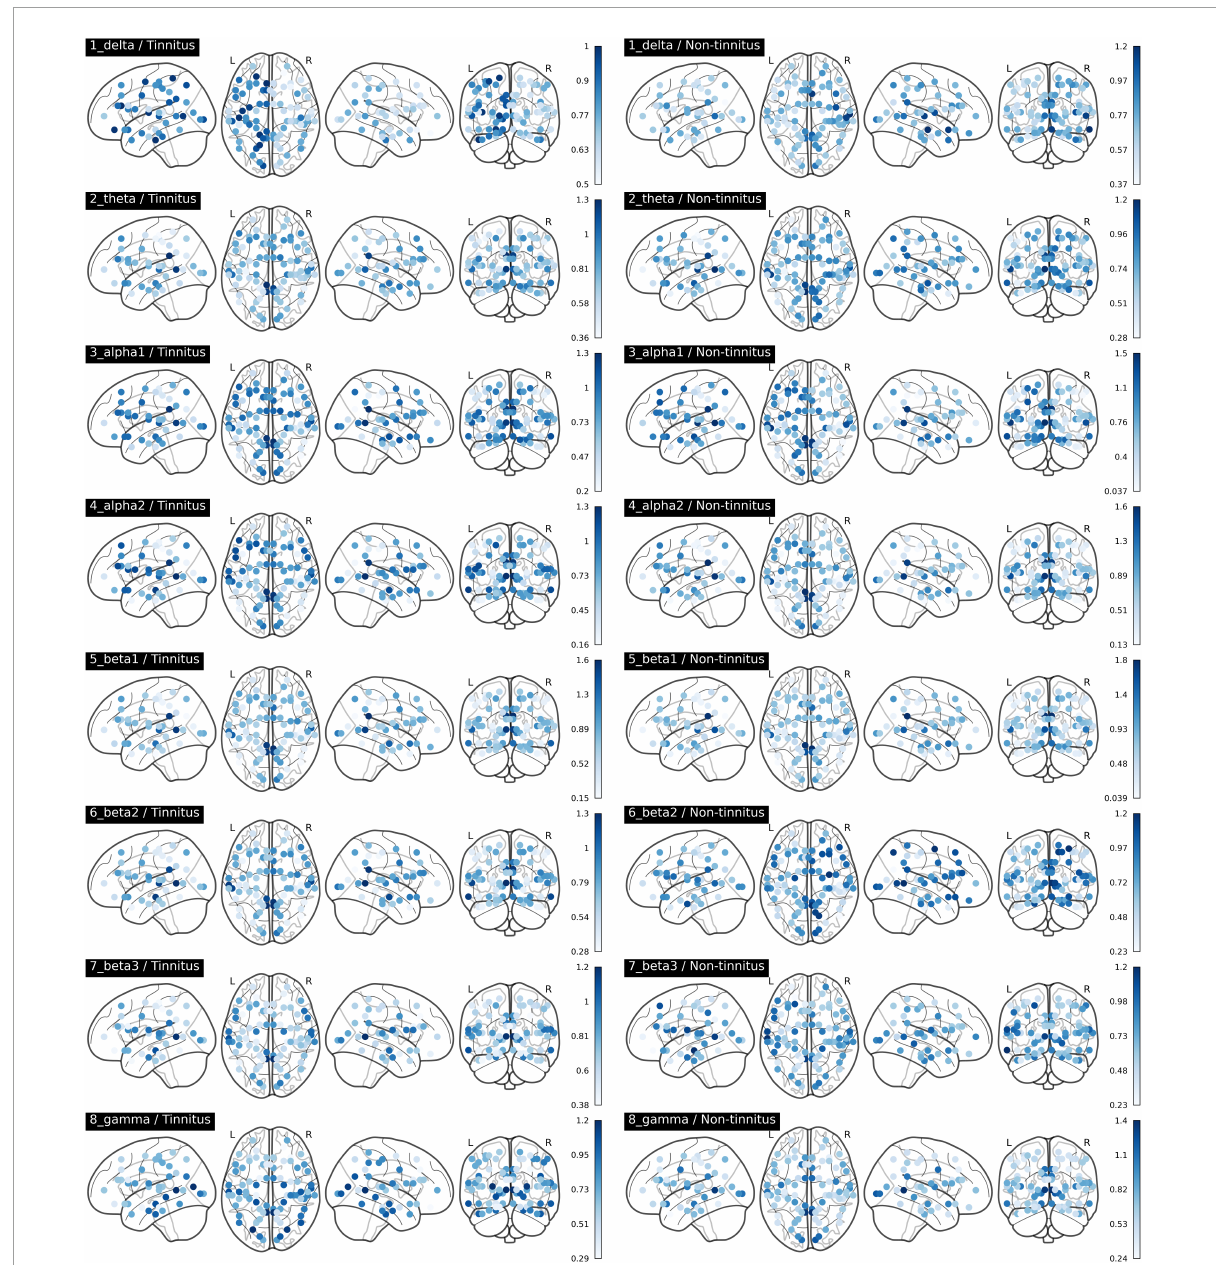
FIGURE3 Afferent node capacity in all regions of interest in Brodmann areas, for all frequency bands ( p < 0.05). The figures were generated using the Nilearn (version 0.2.5) Python package. The color scales of blue dots represent the average afferent node capacities at each Brodmann area of the sudden sensorineural hearing loss patients with- and without tinnitus groups; darker dots represent higher afferent node